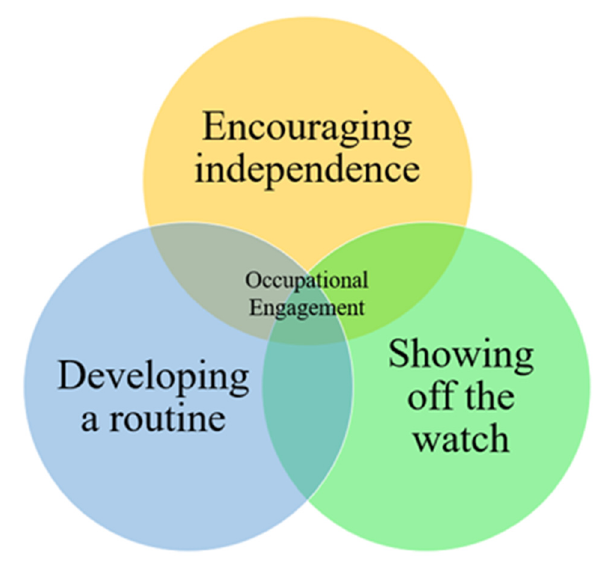
Figure 7. Venn diagram illustrating the overlap between the three identified themes to produce occupational engagement.